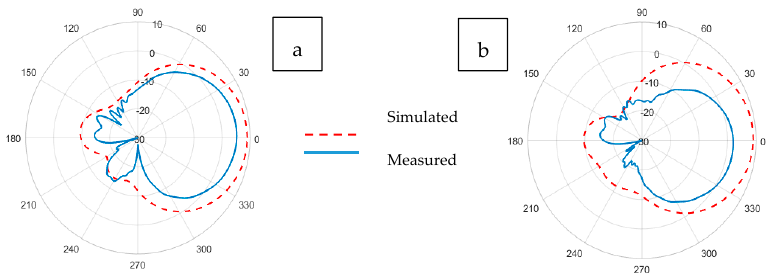
Figure 12. Simulated and experimental ( a ) E-plane and ( b ) H-plane radiation patterns of Prag-based perforated RRMPA at 2.45 GHz.